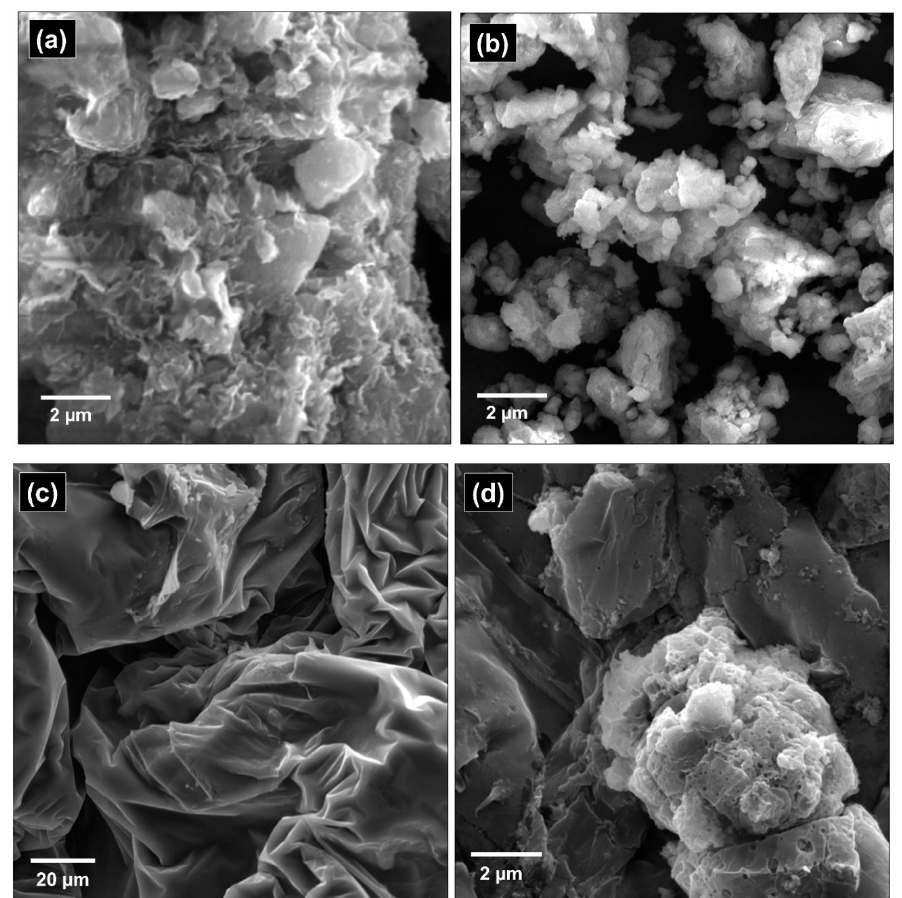
Figure 7. SEM images of: ( a ) Pure montmorillonite clay; ( b ) Organo-modified montmorillonite clay; ( c ) Phenol furfural resin; ( d ) Phenol-furfural resin/organo modified MMT clay composite.